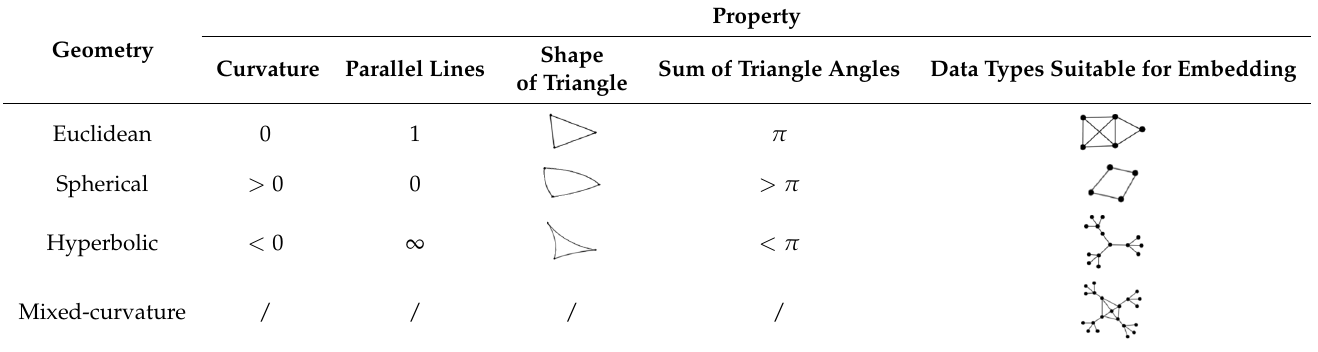
Table 3. Summary of curvature space properties.